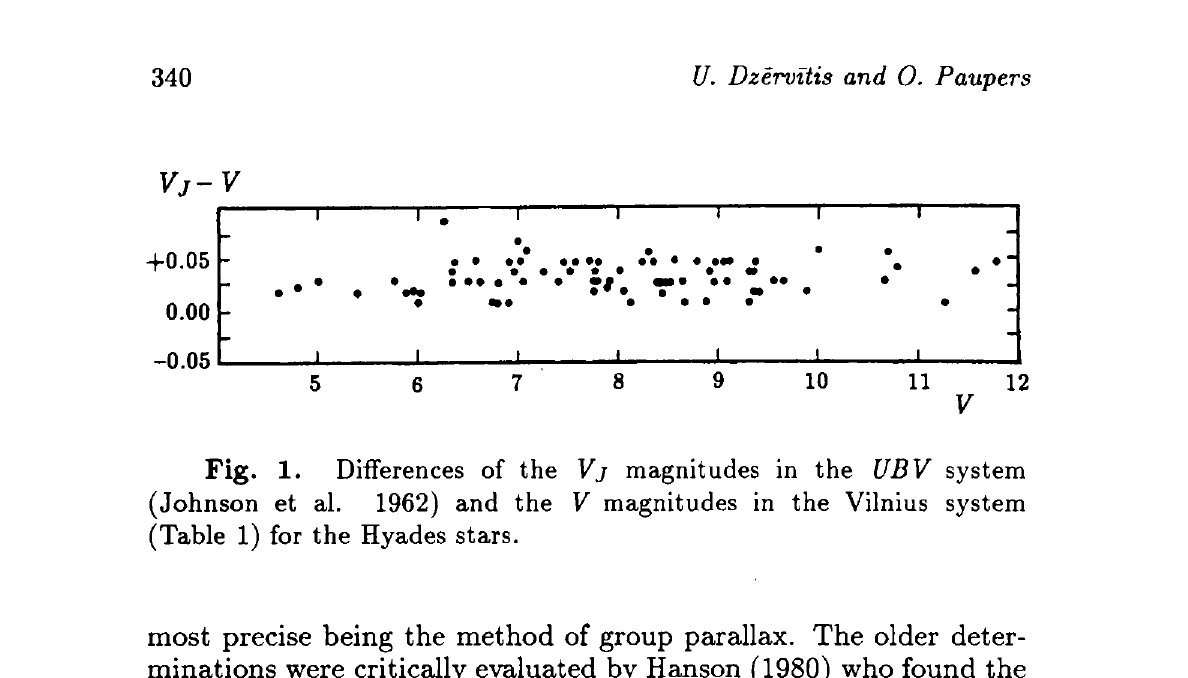
Fig. 1. Differences of the Vj magnitudes in the UBV system (Johnson et al. 1962) and the V magnitudes in the Vilnius system (Table 1) for the Hyades